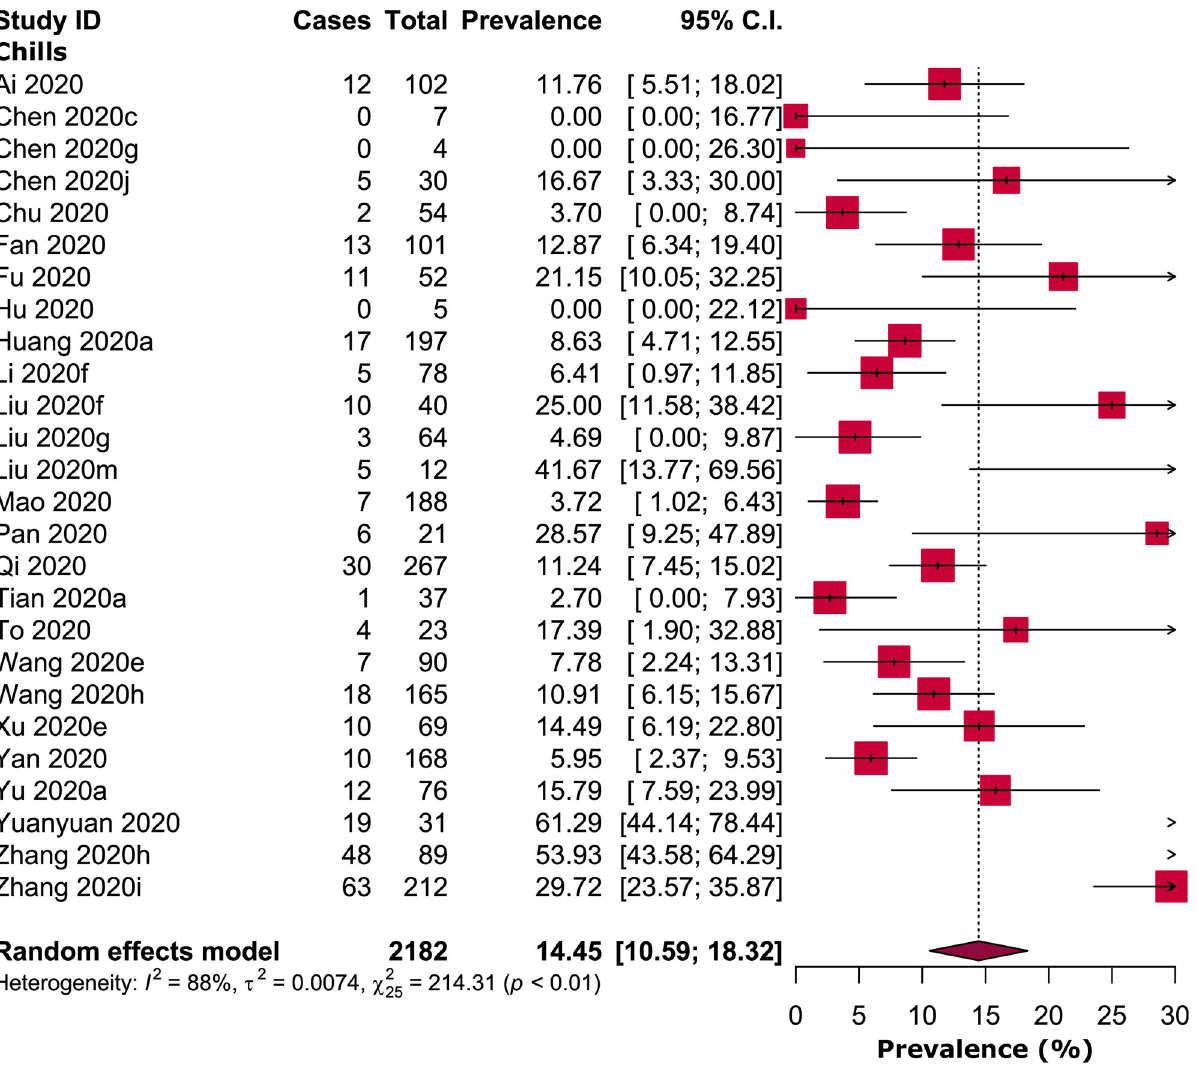
Fig 2. Prevalence of chills in adult COVID-19 patients. patients (RR: 1.07, 95% CI: 0.99–1.15; p = 0.07, I 2 = 75%) (Table 2; Fig 3; S3 Fig). In pregnant women or new mothers, the prevalence of fever was 56.45% [95% CI: 40.15–72.75, I 2 = 89%] (Table 2; S3 Fig). In adult COVID-19 patients, among different grades of fever, the prevalence of medium- grade fever (44.33%) was higher compared to low- (38.16%) and high-grade fever (14.71%). In addition, the risk of both low (RR: 2.34, 95% CI: 1.69–3.22, p < 0.00001) and medium grade fever (RR: 2.79, 95% CI: 2.21–3.51, p < 0.00001) were significantly higher compared to high- grade fever, however, there was no significant difference between low- and medium-grade fever (RR: 1.17, 95% CI: 0.94–1.44, p = 0.16) (Figs 4 and 5; Table 3). In different subgroups of COVID-19 patients, the prevalence of low and medium-grade fever was found significantly higher in non-severe (prevalence: 36.16%, RR: 2.50, 95% CI: 1.32–4.73, p = 0.005, I 2 = 88% and prevalence: 43.90%, RR: 2.72, 95% CI: 1.89–3.90, p = 0.00001, I 2 = 0%; respectively) and non-survived adult COVID-19 patients (prevalence: